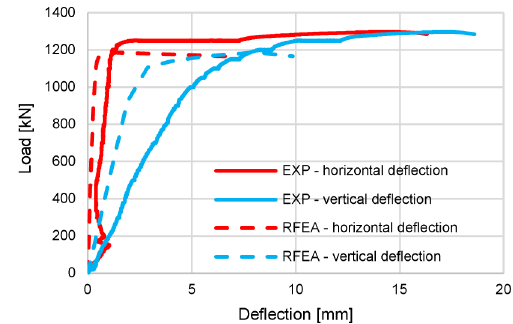
Fig. 14. Load-deflection curve for specimen E